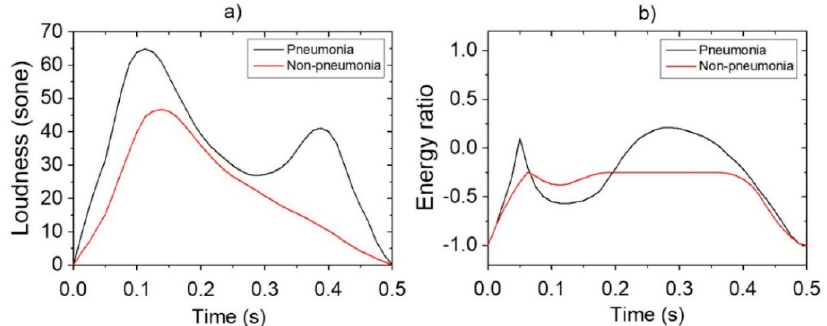
Figure 3. Pre ‐ processing of features for data augmentation: ( a ) loudness; ( b ) energy ratio.